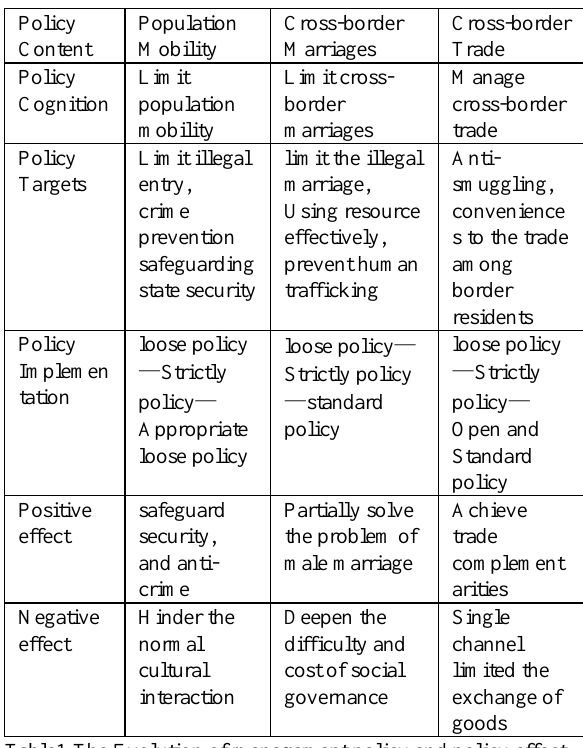
Table1 The Evolution of management policy and policy effect evaluation in